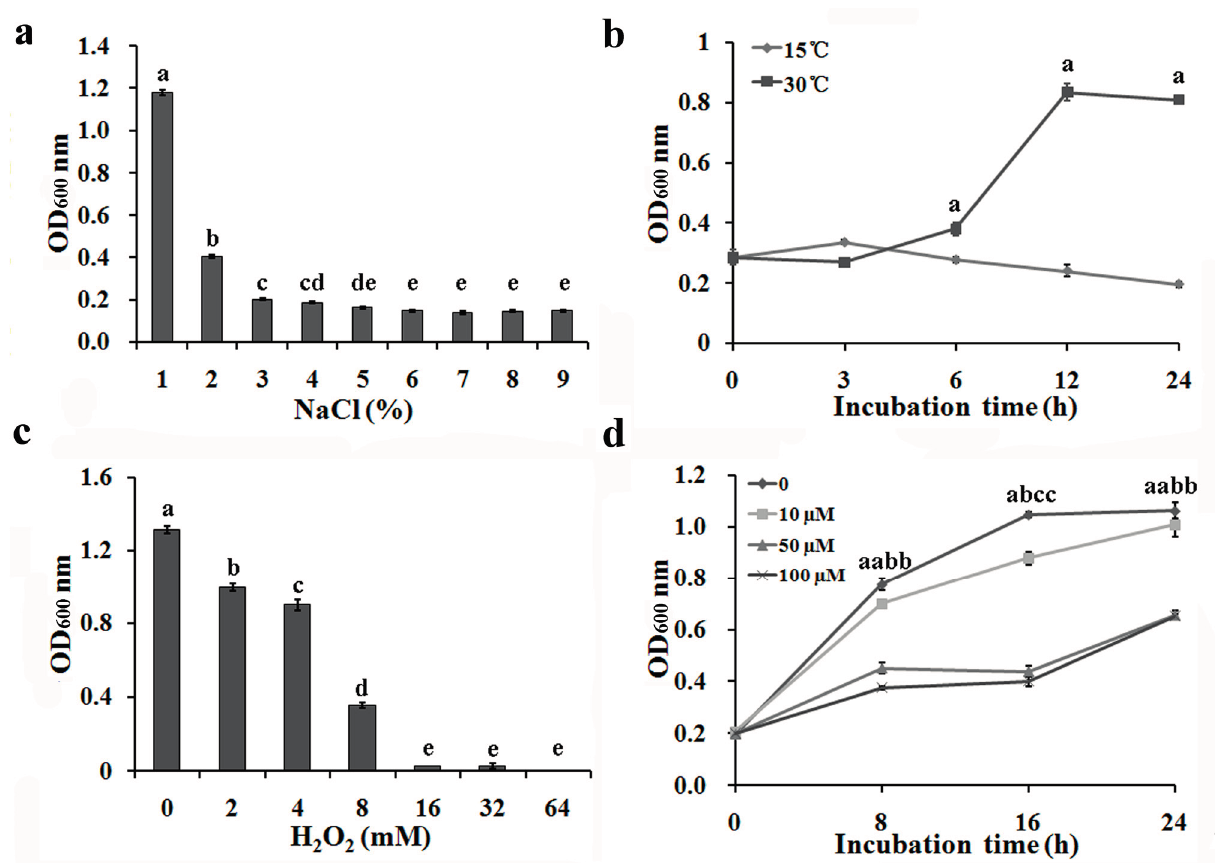
Figure 1. Growth of Acidovorax avenae subsp. avenae RS-1 under different conditions of ( a ) NaCl-induced osmotic stress; ( b ) low temperature stress; ( c ) H 2 O 2 -mediated oxidative stress; ( d ) paraquat-mediated oxidative stress ( p < 0.05). Aaa RS-1 incubated in NA broth with 1.0% NaCl at 30 °C, 200 rpm for 24 h was used as the negative control. Data from the repeated experiment were pooled and subjected to analysis of variance. Columns with the same letters (a–e) are not significantly different ( p = 0.05). Error bars represent the standard error of the